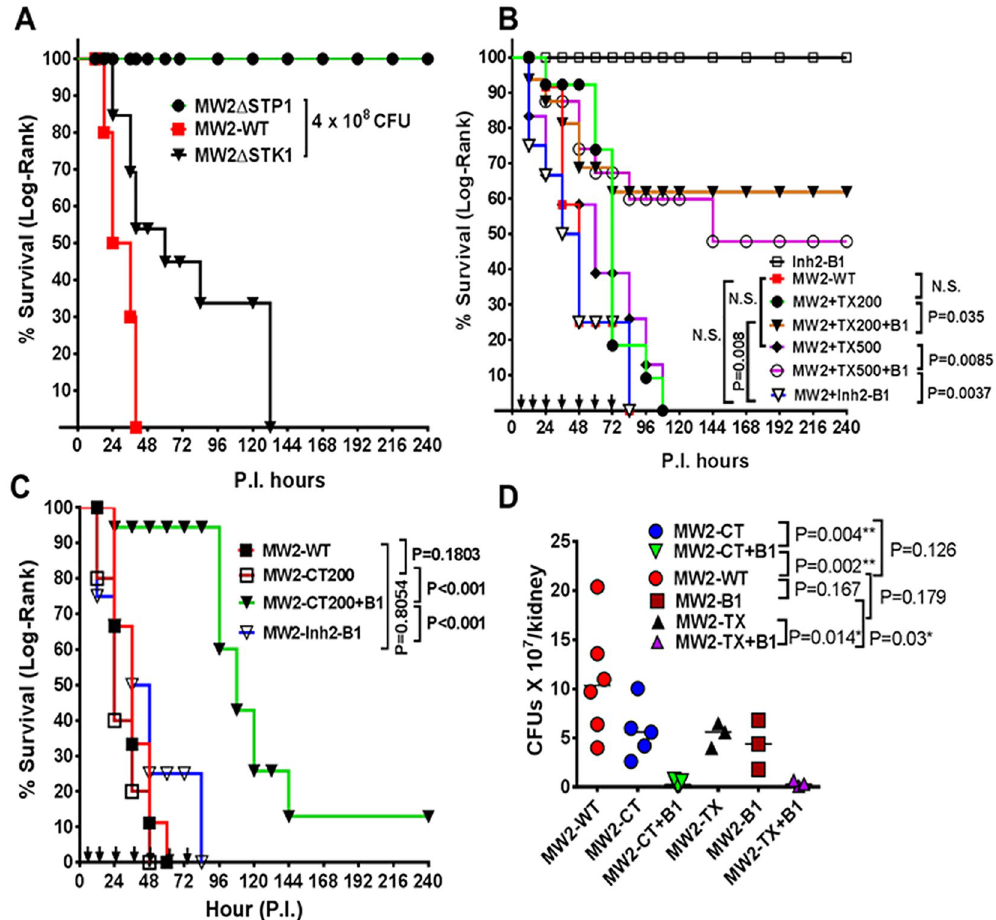
Figure 8. Inh2-B1 enhances the in vivo bactericidal activity of Ceftriaxone and Cefotaxime in the S . aureus mouse septicemia model. ( A ) Effect of the deletion of the genes encoding STK1 and STP1 on the virulence of S . aureus MW2 strain in the mouse septicemia model. A group of 10 CD-1 female mice (~20 g) were challenged retro-orbitally with S . aureus MW2-WT wild-type, MW2 Δ STK1 or MW2 Δ STP1 mutant strains (4.0 × 10 8 CFU/100 µ l) and were observed for ten days for mortality and morbidity. ( B ) Effect of treatment with only Inh2-B1 (5 mg/kg body weight) or Ceftriaxone (10 and 25 mg/kg body weight i.e. 200 and 500 µ g/ mouse), and combination of Inh2-B1 (5 mg/kg, 100 µ g/mouse) and Ceftriaxone (10 and 25 mg/kg, 200 and 500 µ g/mouse) on mice challenged with a lethal dose (4.0 × 10 8 CFU/100 µ l) of the MW2-WT strain. ( C ) Effect of treatment with only Cefotaxime (10 mg kg/body weight, 200 µ g/mouse), and combination of Inh2-B1 (5 mg/ kg body weight, 100 µ g/mouse) and Cefotaxime (10 mg/kg body weight, 200 µ g/mouse) on mice challenged with a lethal dose (4.0 × 10 8 CFU/100 µ l) of the MW2-WT strain. Mice were treated every 12 h for four days as described in detail in the text (arrows on the X-axis) and were observed for ten days for morbidity and mortality. P values less than 0.05 were treated as significant and were determined by the Log-Rank test using GraphPad Prism 6 software. N.S. not significant. ( D ) Determination of colony forming units in kidneys of treated and untreated challenged mice. To obtain relative differential bacterial loads in different treated and untreated challenged groups, 3–6 mice were sacrificed on Day 3 P.I The tissue extracts of kidneys were appropriately diluted, and CFUs were counted on tryptic soy agar (TSA). Results were statistically analyzed based on the median values obtained from each group (WT, CT, TX, B1, CT + B1 and TX + B1) using t-test with Welch correction. P value less than 0.05 was treated as significant. WT- wild-type, CT, –Cefotaxime, TX, Ceftriaxone, B1-